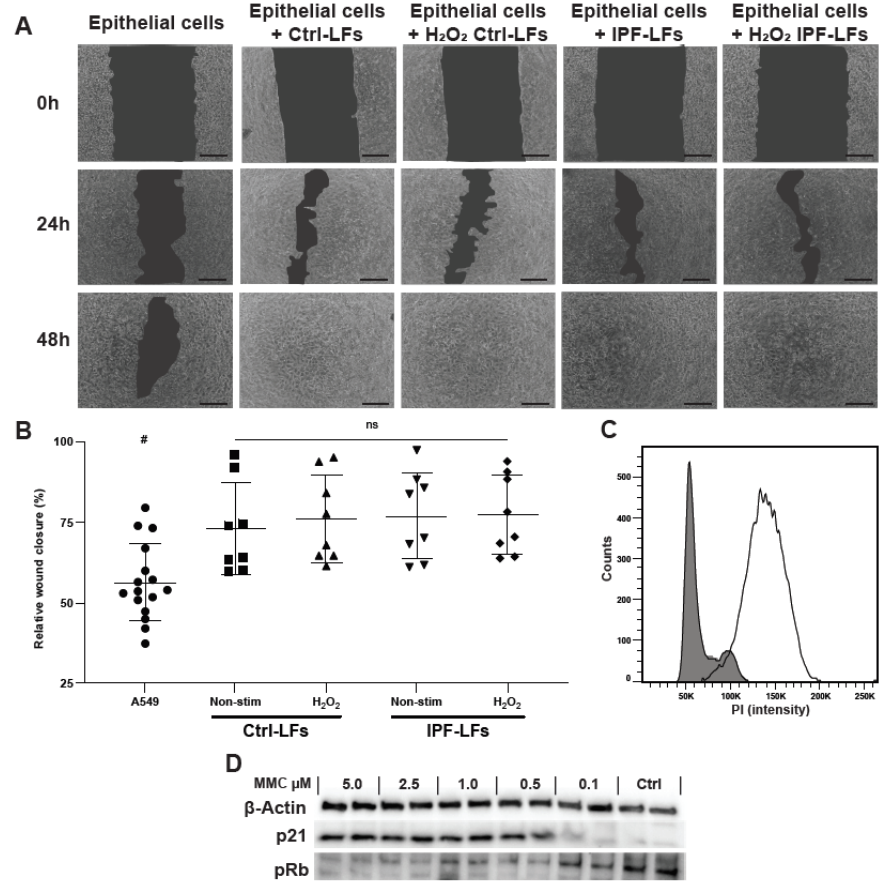
Figure 4. Fibroblasts increase alveolar epithelial cell migration in co-culture. ( A ) A549 cells were grown to confluence, treated with 0.5 µ M MMC for 2 h before a scratch-wound was introduced. Fibroblast senescence was induced by stimulation with 150 µ M H 2 O 2 for 2 h. ( A ) The mechanically injured A549 cells were cultured alone ( n = 16) or in combination with Ctrl-LFs ( n = 8) or IPF-LFs ( n = 8), and migration was followed up for 48h. ( B ) The relative rate of wound closure after 24 h was calculated based on surface area of the scratch using ImageJ. Data are expressed as relative wound closure in percentage after 24 h ± SD. # A549 cell wound closure at 24 h was tested significant different compared to all other conditions using Mann–Whitney U test for each co-culture condition ( p < 0.05). ( C , D ) MMC concentration was titrated followed by cell-cycle and immunoblotting to select for optimal concentration. Scale bar: 250 nm.